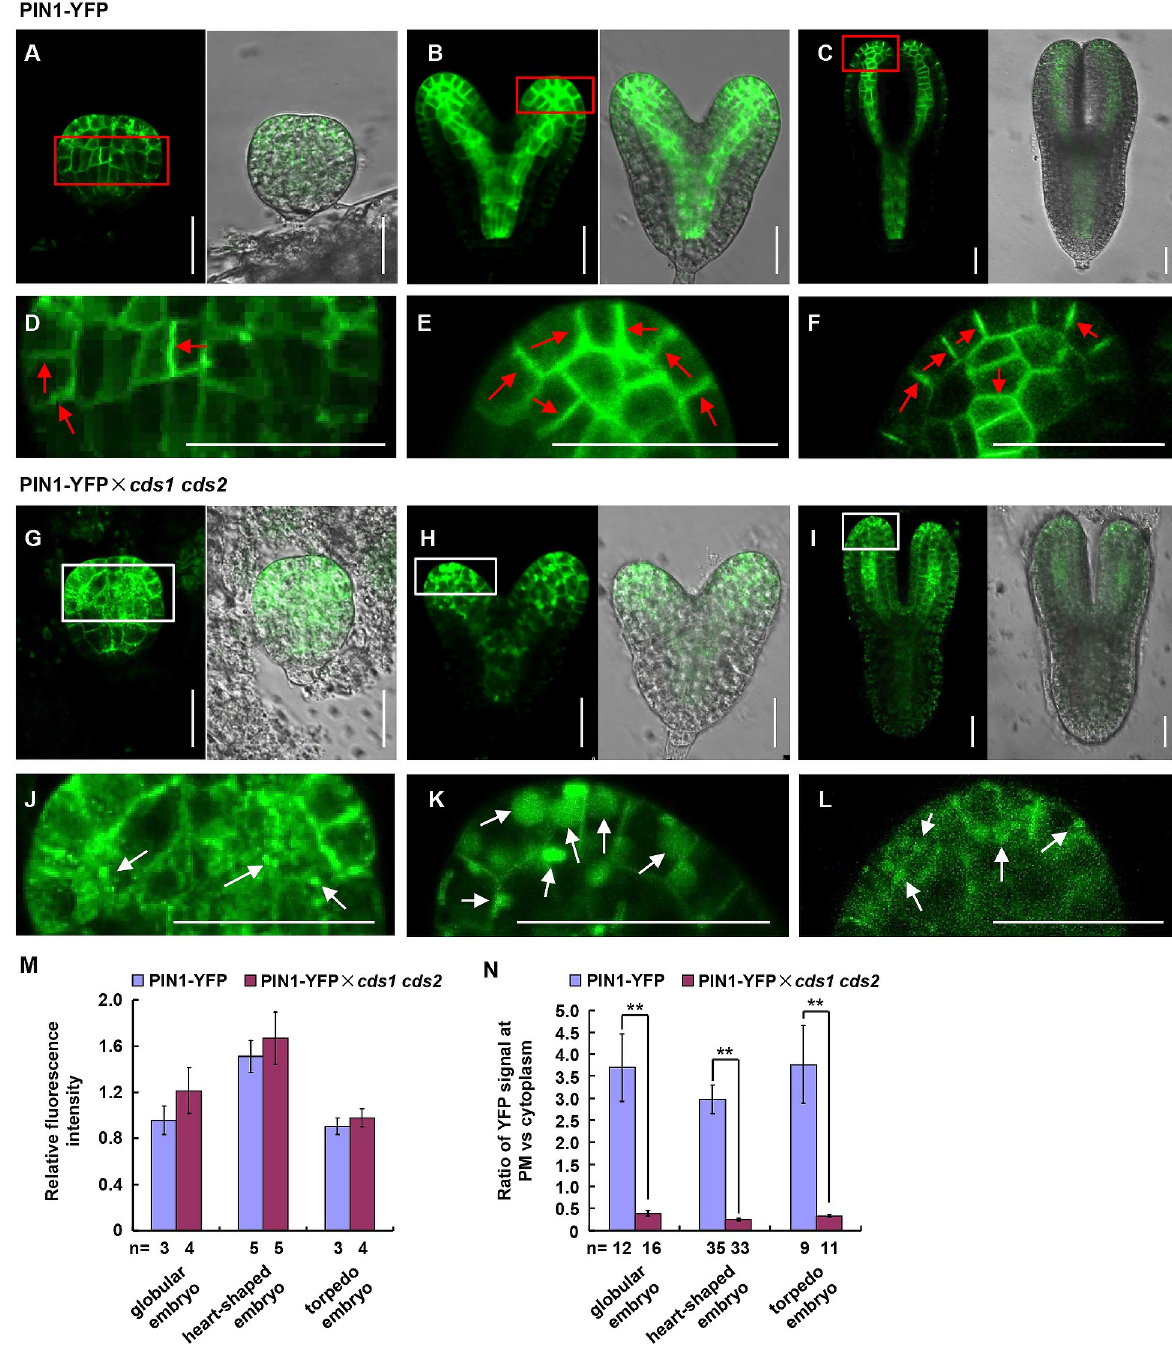
Fig 5. Disturbed polar localization of auxin efflux carrier PIN1 under suppressed expression of CDS1 and CDS2 . (A-L) Subcellular localization of auxin efflux carrier PIN1 in embryos at different developmental stages of Col and cds1 cds2 , including globular embryo (A, G), heart-shaped embryo (B, H) and torpedo embryo (C, I). (D-F) Enlargement of A-C, respectively. Red arrows highlighted the polar localization of PIN1 at plasma membrane. (J-L) Enlargement of G-I, respectively. White arrows highlighted the dot structure of PIN1 in cytoplasm. Arabidopsis line harboring PIN1-YFP fusion protein or offsprings of PIN1-YFP cross with cds1 cds2 (PIN1-YFP × cds1 cds2 ) were analyzed. Observations were performed with 2 independent lines and representative images were shown. Bars = 25 μ m. (M-N) Relative YFP fluorescence intensity (M) and ratio of YFP signal intensity at PM to cytoplasm (N) at different embryo developmental stages in PIN1-YFP and PIN1-YFP × cds1 cds2 . Numbers of analyzed embryos or cells (n) from 2 independent experiments were indicated. Values were mean ± SE. Statistical significance was determined by student’s t test ( �� , p <